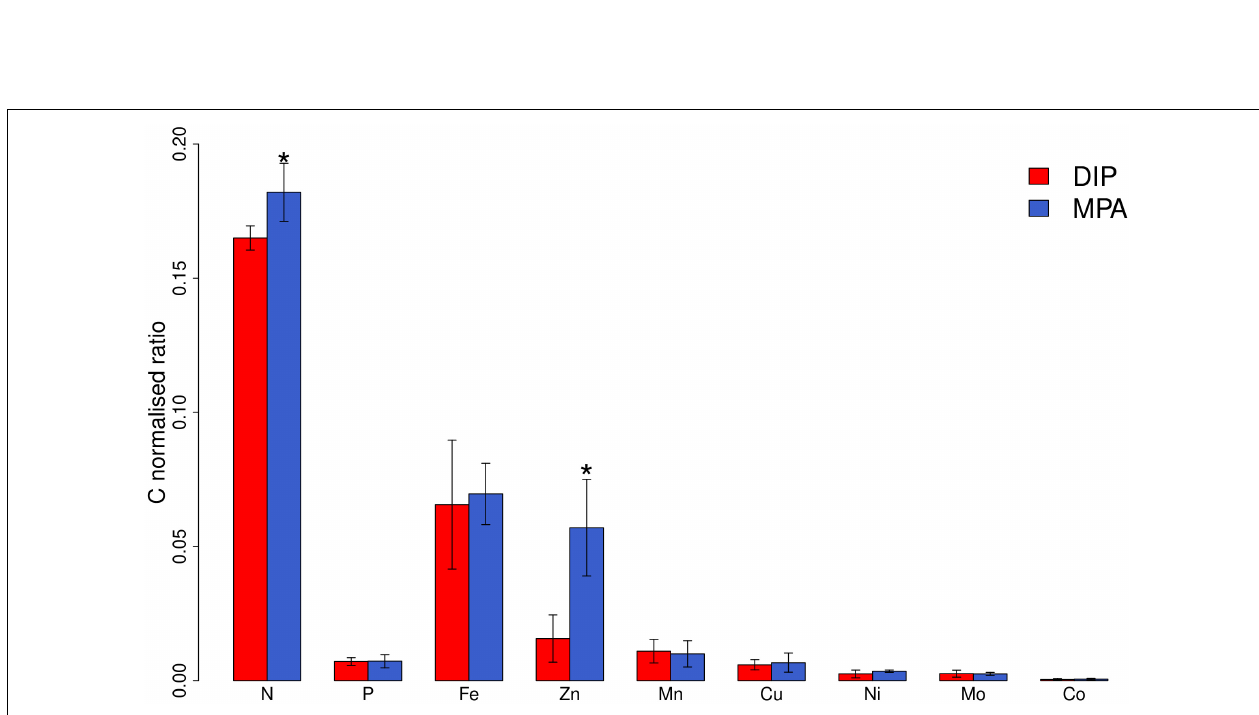
FIGURE 2 | Elemental composition of Trichodesmium ISM101 at steady state (day ≥ 21) grown under supply of DIP and MPA. Bars show mean steady-state elemental ratios; error bars are standard deviation ( n = 7–12). N and P are in units of mol:mol; all others are in units of mmol:mol. *Statistically significant differences between treatments (pairwise Wilcox test, p < 0.05). We note that mean steady-state particulate Fe:C ratios were similar to those found in literature for Trichodesmium (65.6 ± 24 µ mol:mol in comparison with 69.5 ± 3.48 µ mol:mol in Berman-Frank et al. (2001)).